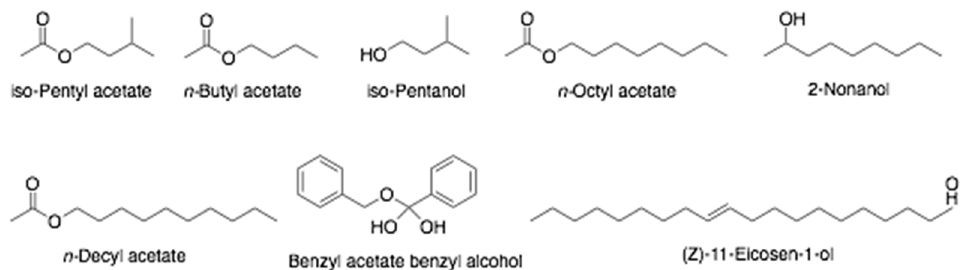
Figure 10. Chemical structures of volatile compounds found in bee venom.